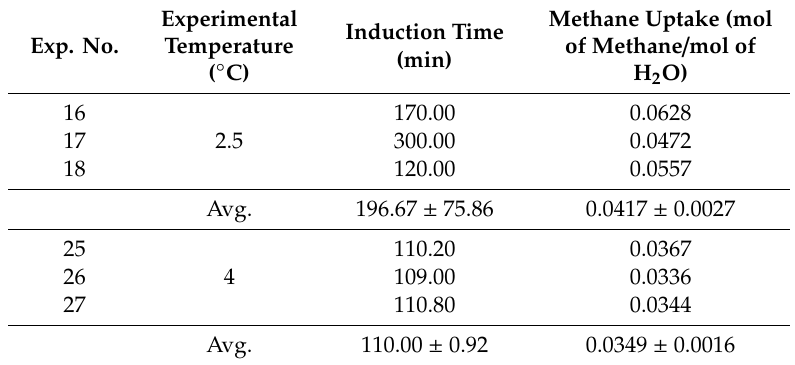
Table 3. Experimental conditions for methane hydrate formation with 15% v / v of CP at 2.5 ◦ C and 4 ◦ C (8 MPa). Experimental Induction Time Exp. No. Temperature ( ◦ C)